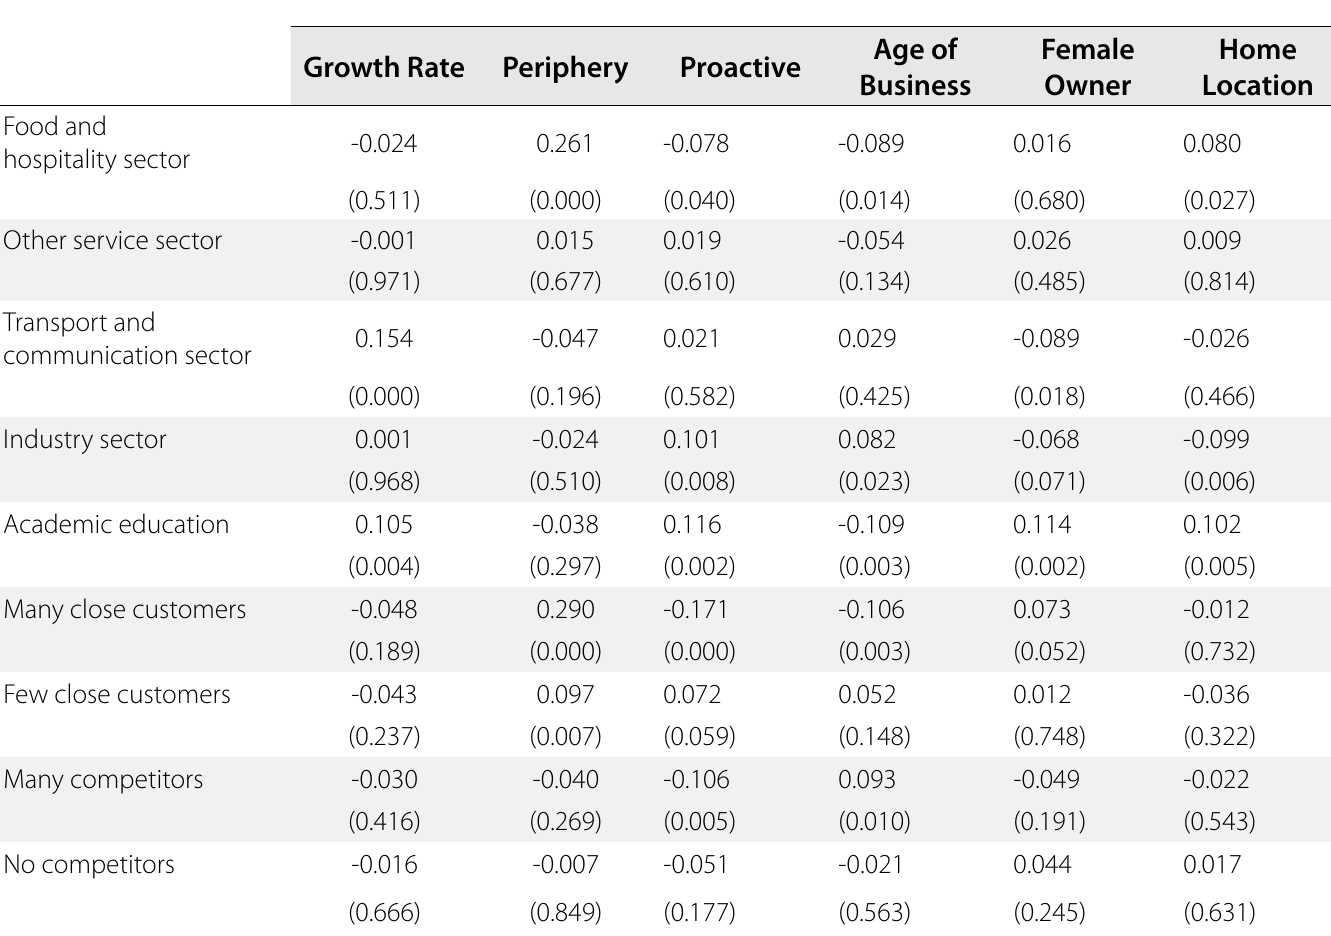
Table 2: Correlations between Variables (n=626; p-values in parentheses)